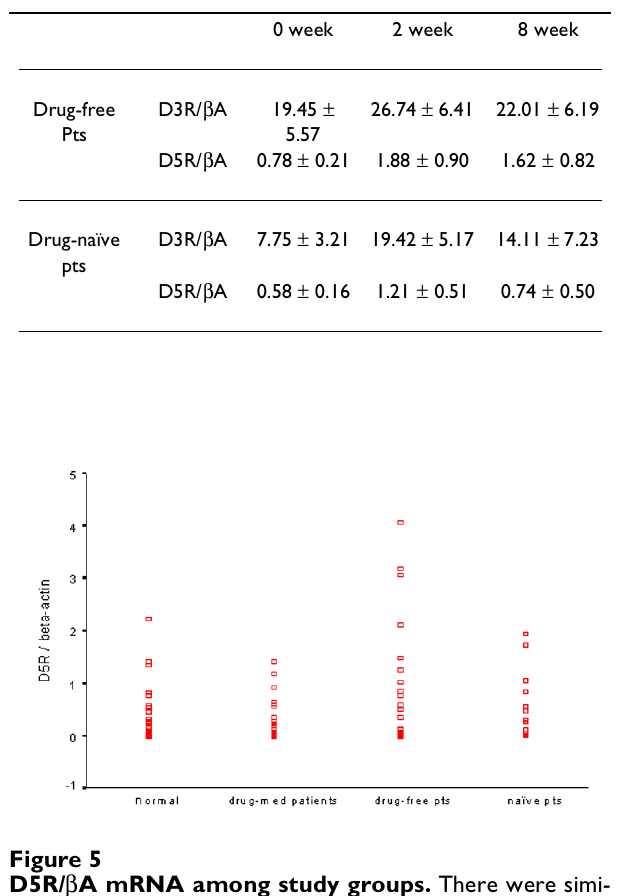
Table 6: Sequential studies of off-medication patients after antip- sychotic medication (mean ± standard error)